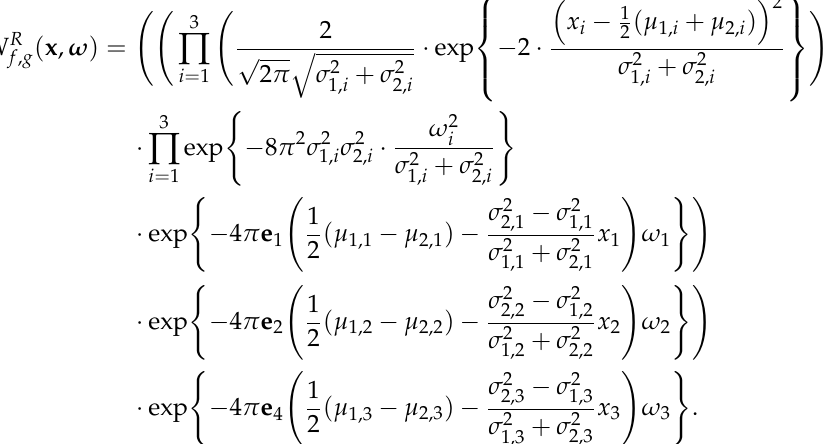
Figure 2. Slices for the volumetric data f and g , where µ σ 1 = ( 0.3,0.1,0.3 ) and σ 2 = ( 0.35,0.5,0.25 )